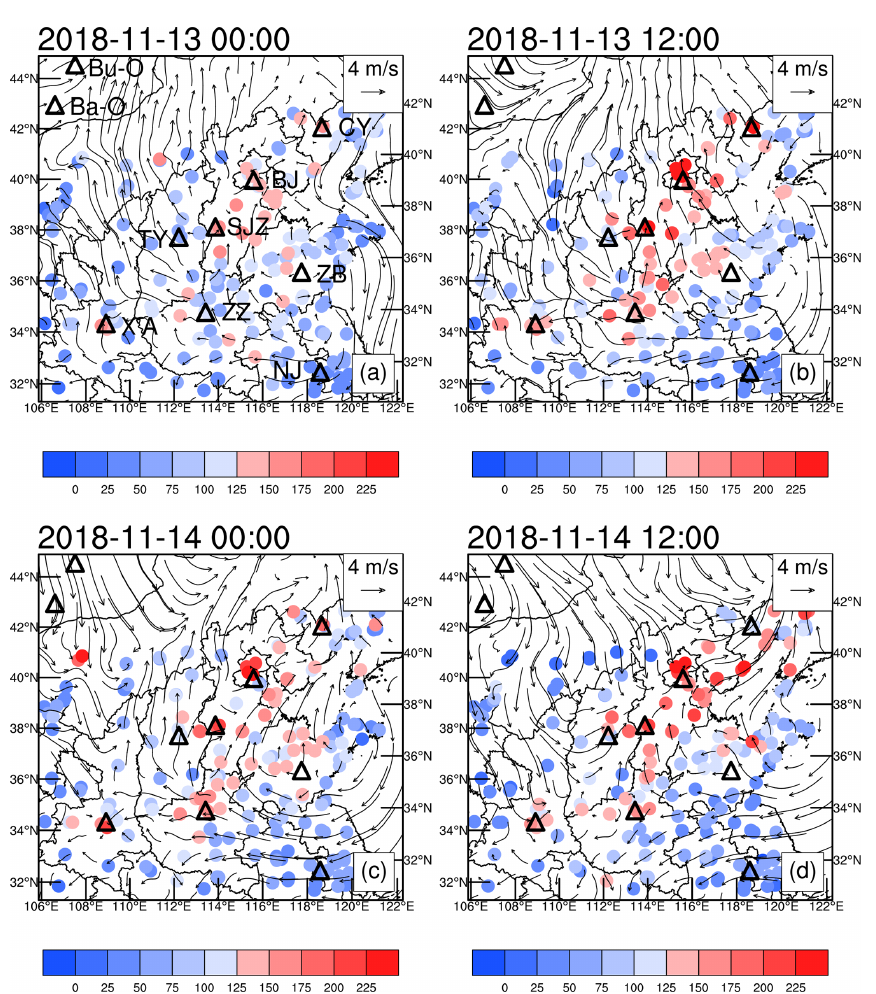
Figure 4. Surface PM 2 . 5 MC measurements in the D02 region and NCEP reanalysis wind field for the period from 00:00UTC on 13 Novem- ber 2018 to 12:00UTC on 14 November 2018 (Bu-O: Buyant-Ovoo; Ba-O: Bayan-Ovoo; CY: Chaoyang; BJ: Beijing; SJZ: Shijiazhuang; TY: Taiyuan; ZB: Zibo; X’A: Xi’an; ZZ: Zhengzhou; NJ: